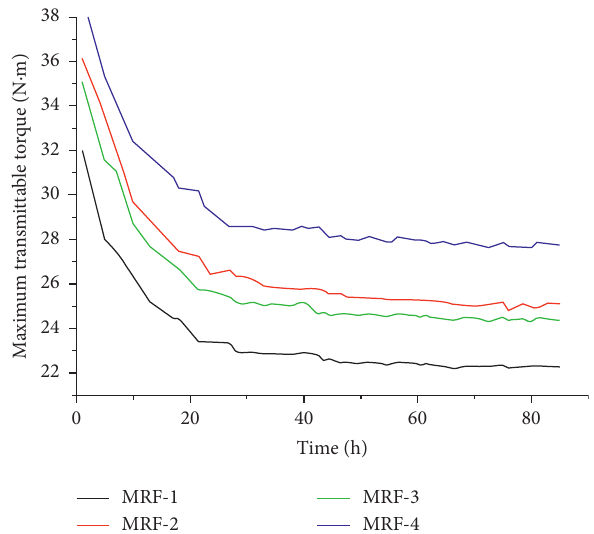
Figure 12: Relationship between maximum transmittable torque of MRF and working time.